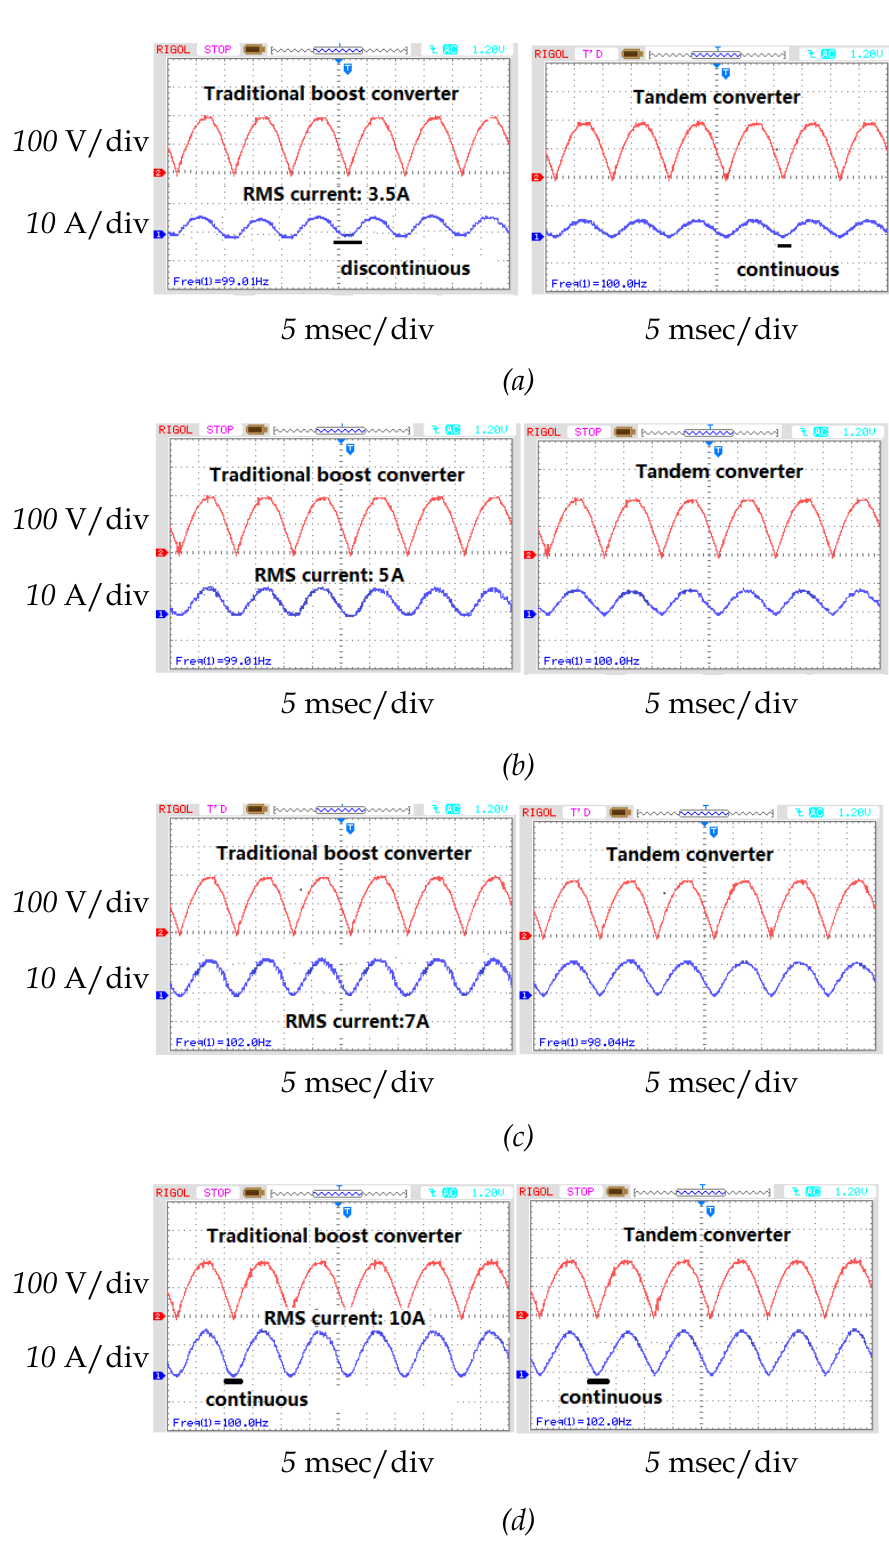
Figure 9. Input current and voltage waveforms of the two converters under low input reference RMS current of ( a ) 3.5 A, ( b ) 5 A, ( c ) 7 A and ( d ) 10